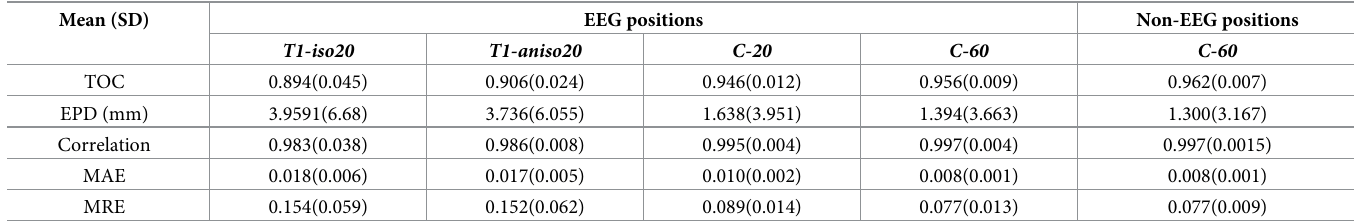
Table 1. Target overlapping coefficient (TOC), E-field peak distance (EPD) error [mm], correlation, mean absolute error (MAE) [V/m] and mean relative error (MRE) and mean directional error (MDE) between the VCM and DNNs on gray matter region of the whole brain for T1-iso20, T1-aniso20, C-20 and C-60 and the rostral middle frontal area for C-60 on brain